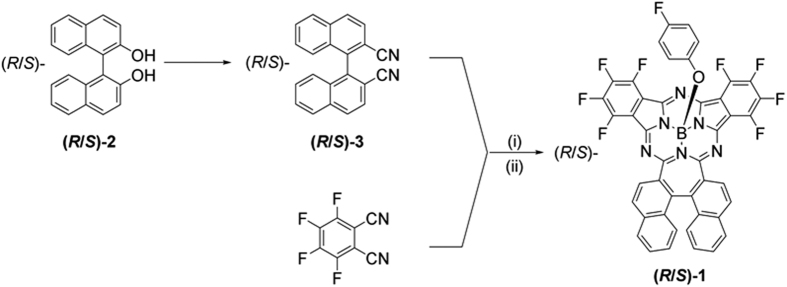
Synthesis of chiral subphthalocyanine analogue (R/S)-1. (i) BBr3, chlorobenzene, 60 °C; (ii) 4-Fluorophenol, 90 °C.